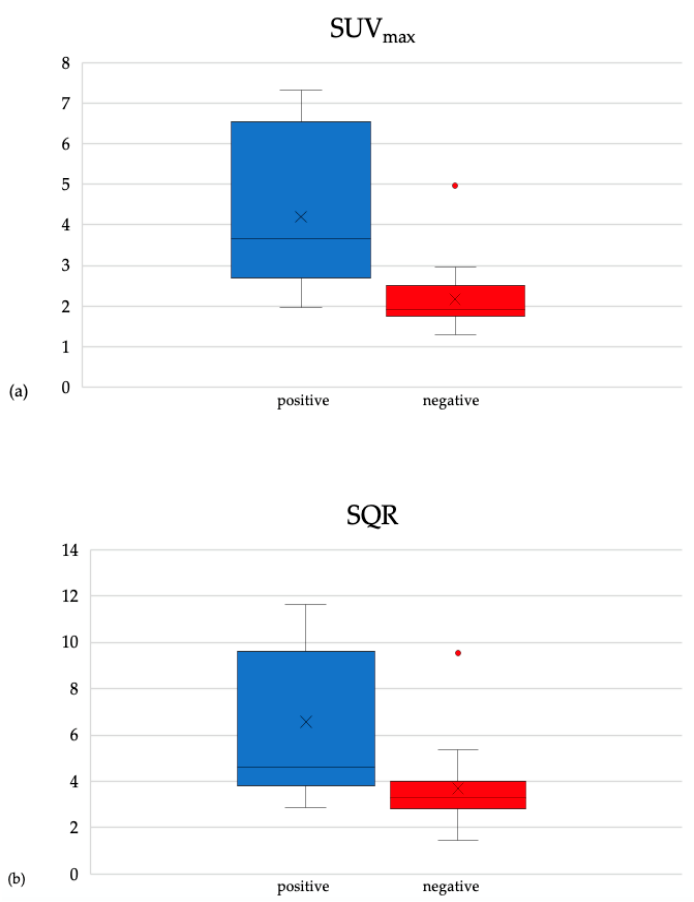
Figure 4. ( a ) SUV max distribution in patients with CIED infection (positive) and patients without CIED infection (negative). ( b ) SQR distribution in patients with CIED infection (positive) and patients without CIED infection (negative).